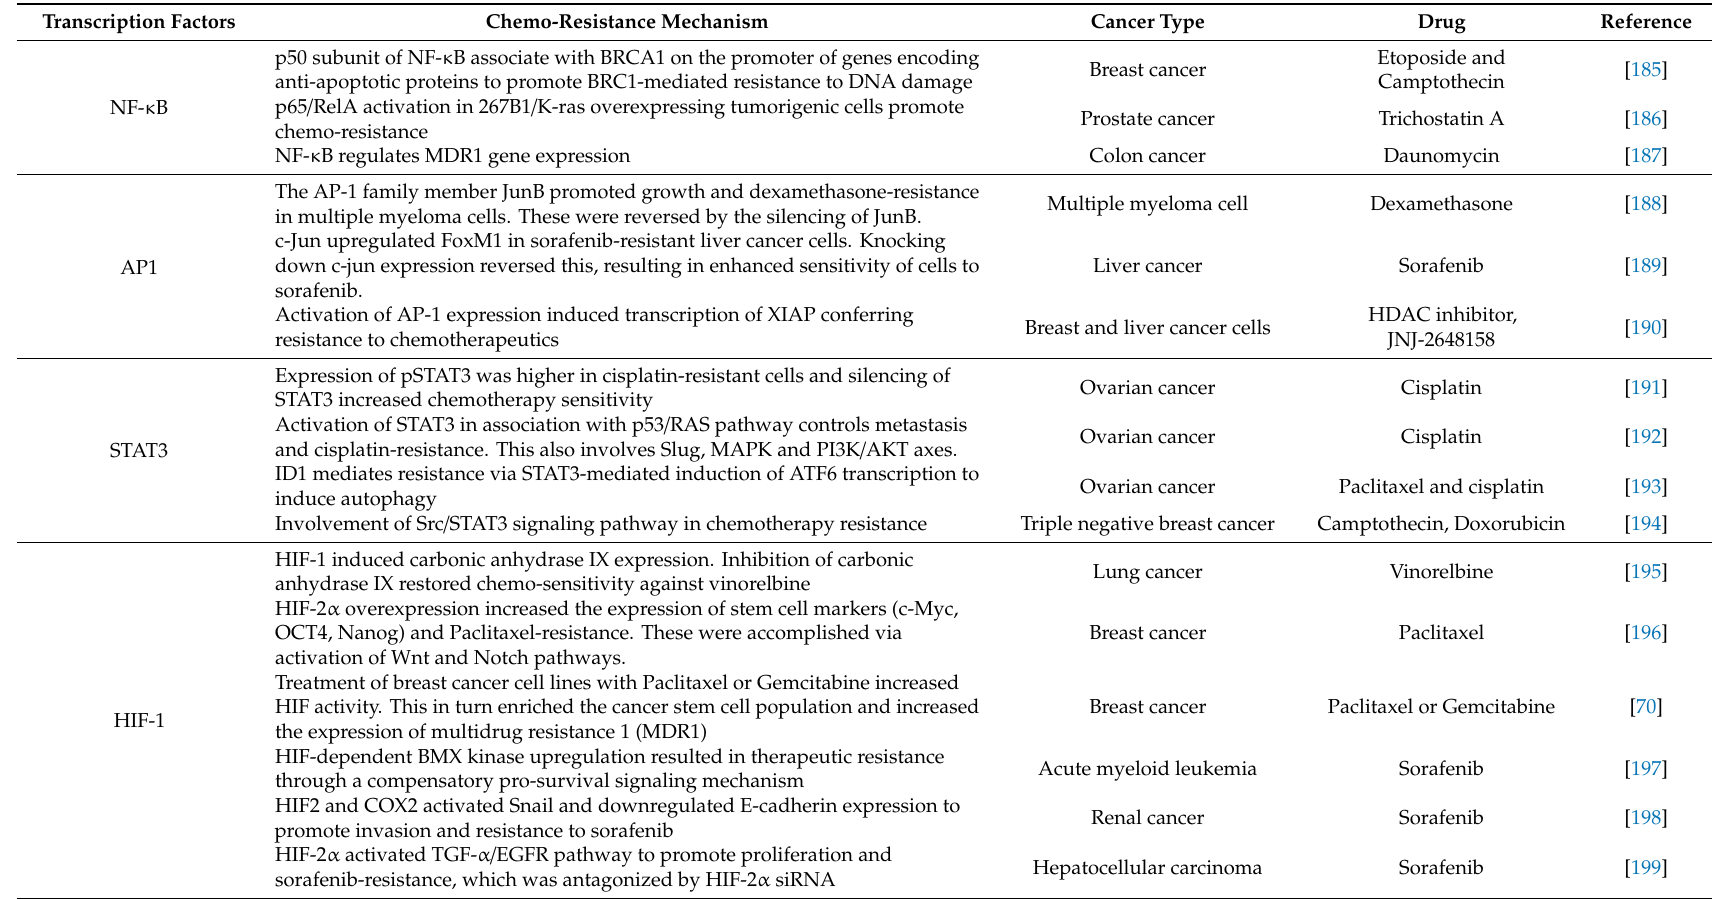
Table 1. Transcription factors in